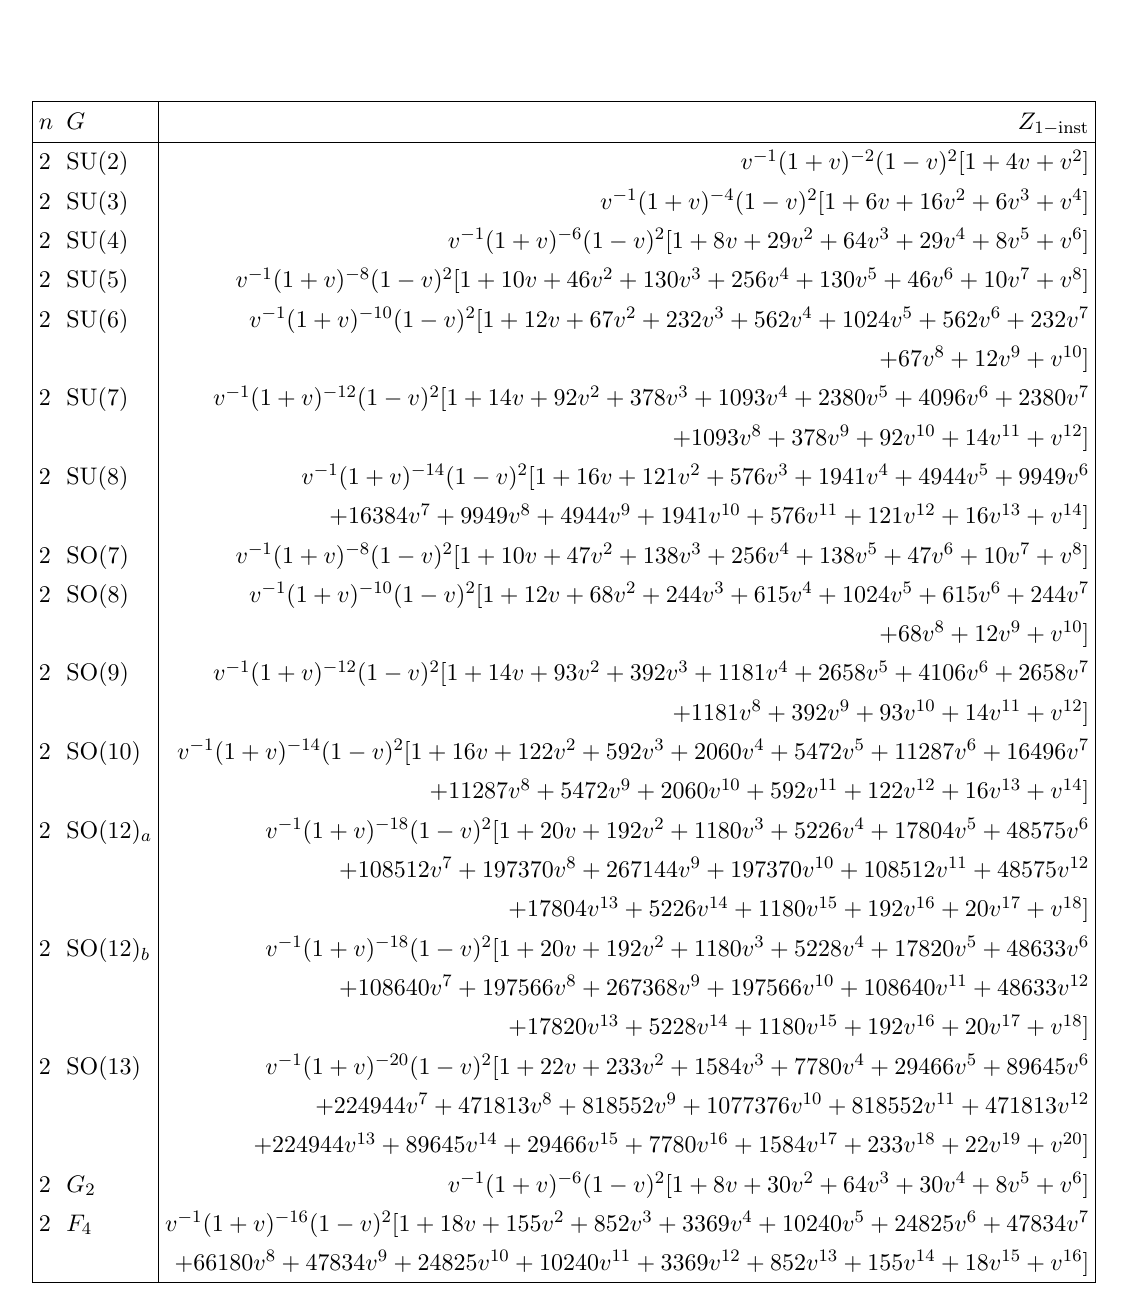
Table 90. 5d limit of the one-string elliptic genus for the theories h G potentials m F ; m G turned o(cid:11). The partition function is displayed with the center of mass factor